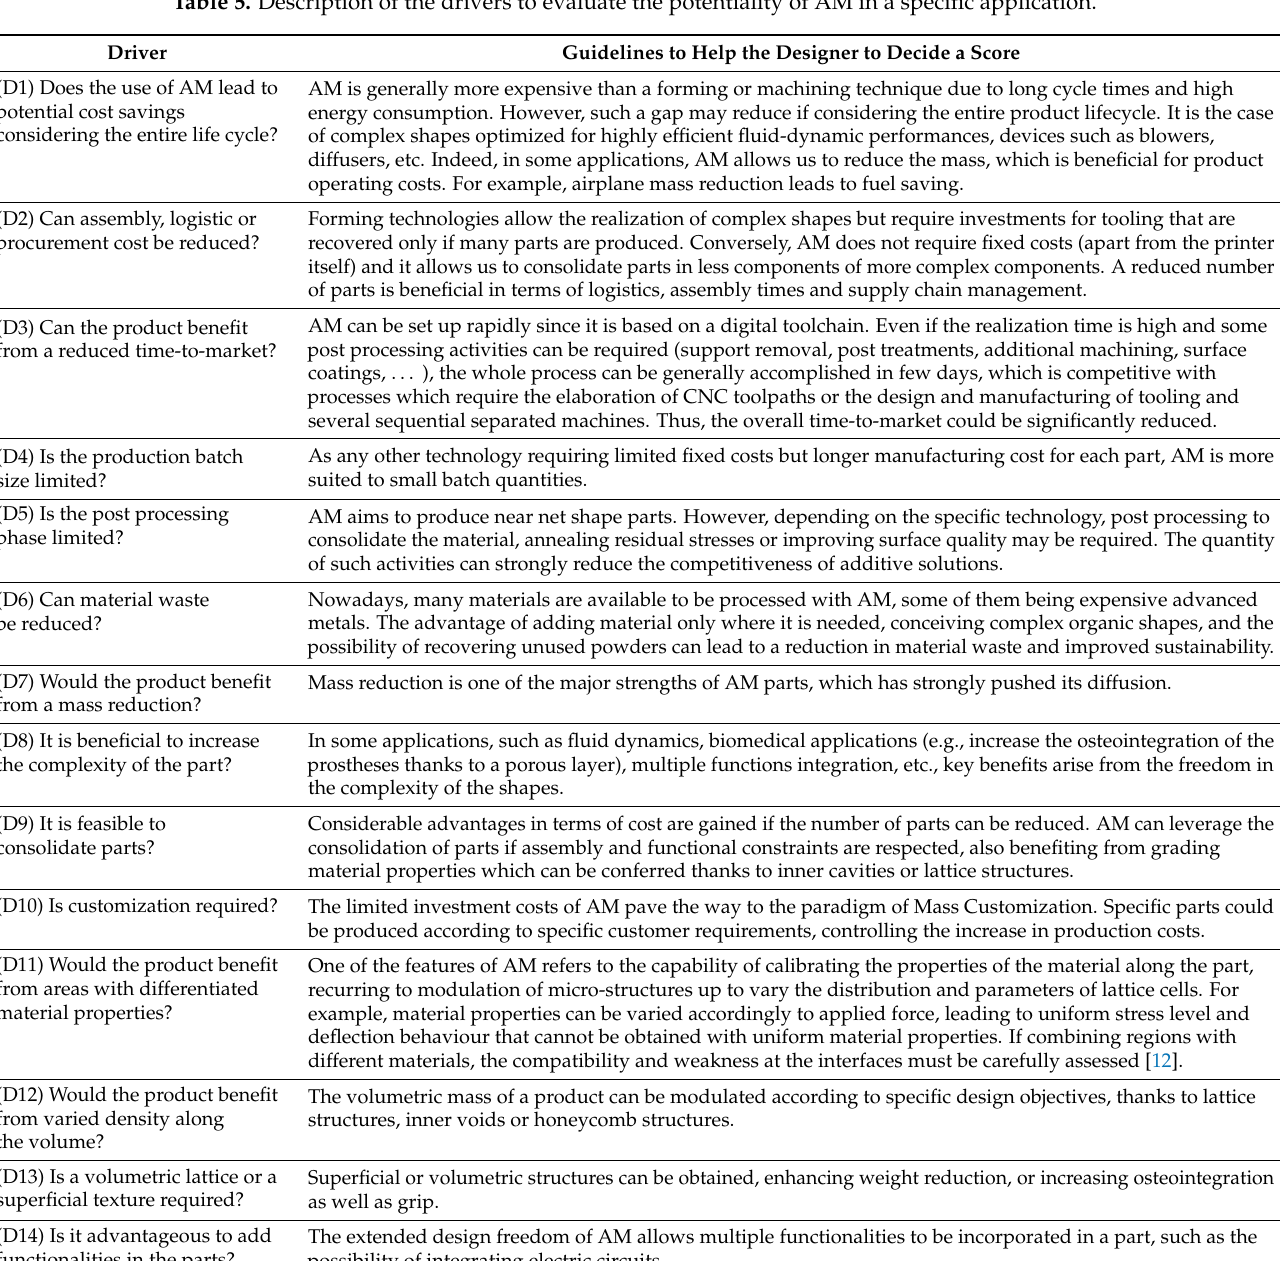
Table 5. Description of the drivers to evaluate the potentiality of AM in a specific